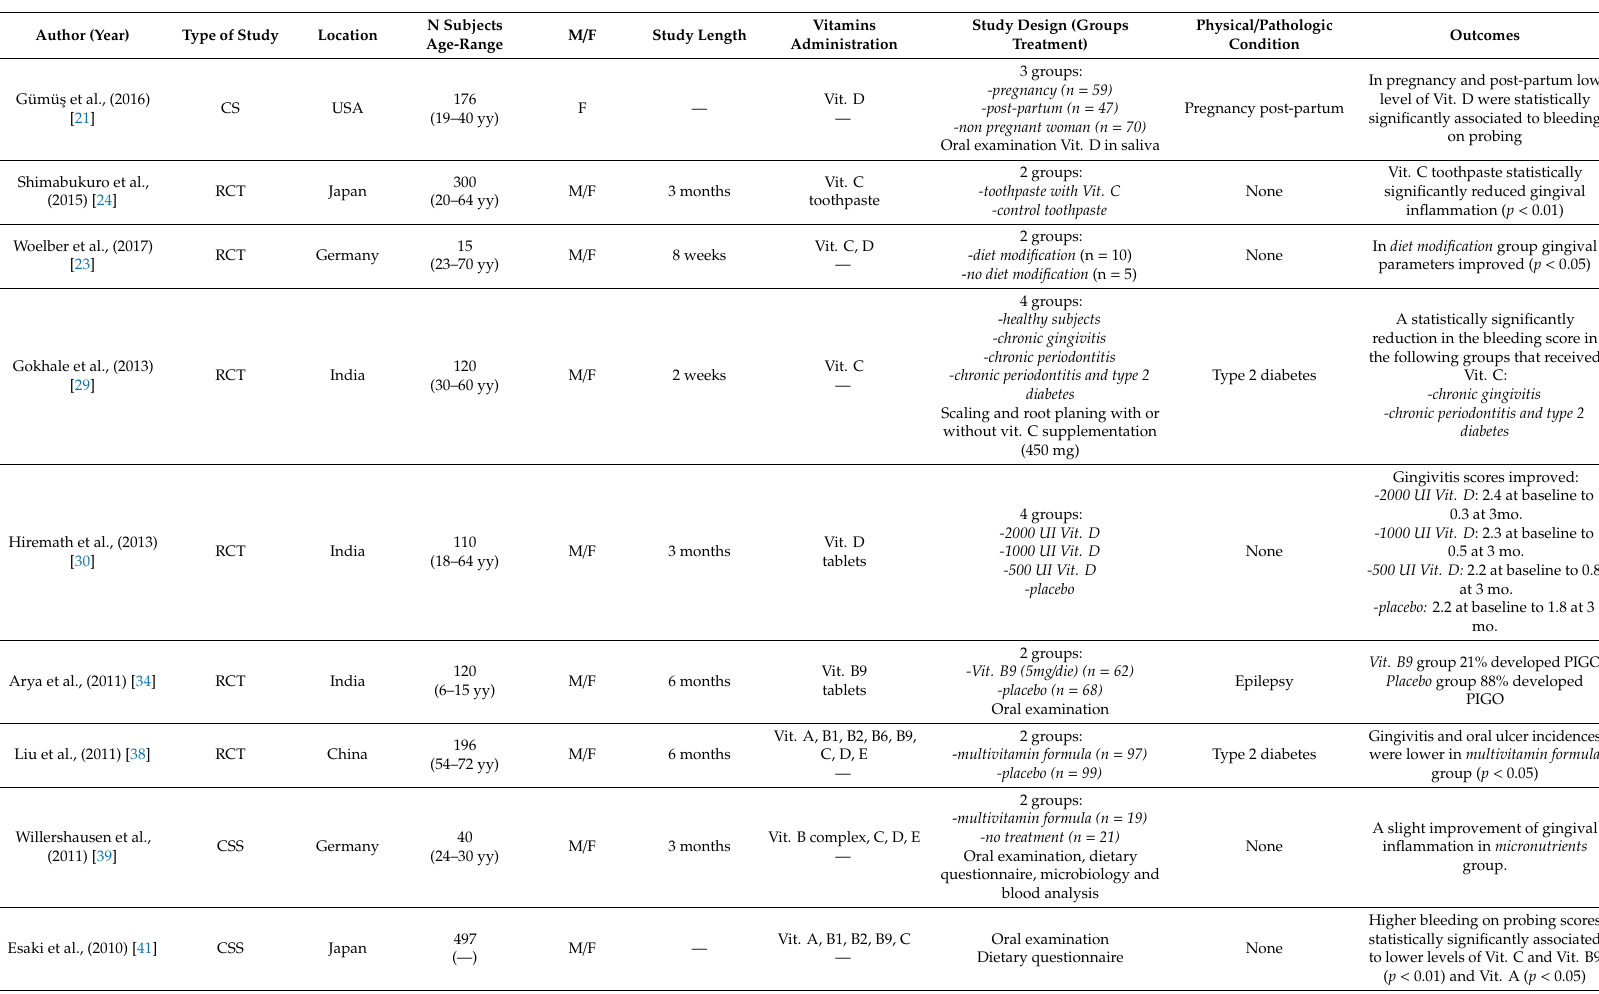
Table 2. Main characteristics of the studies included regarding gingivitis and periodontitis / tooth loss. ( a ) Gingivitis, ( b ) Periodontitis, ( c ) Tooth